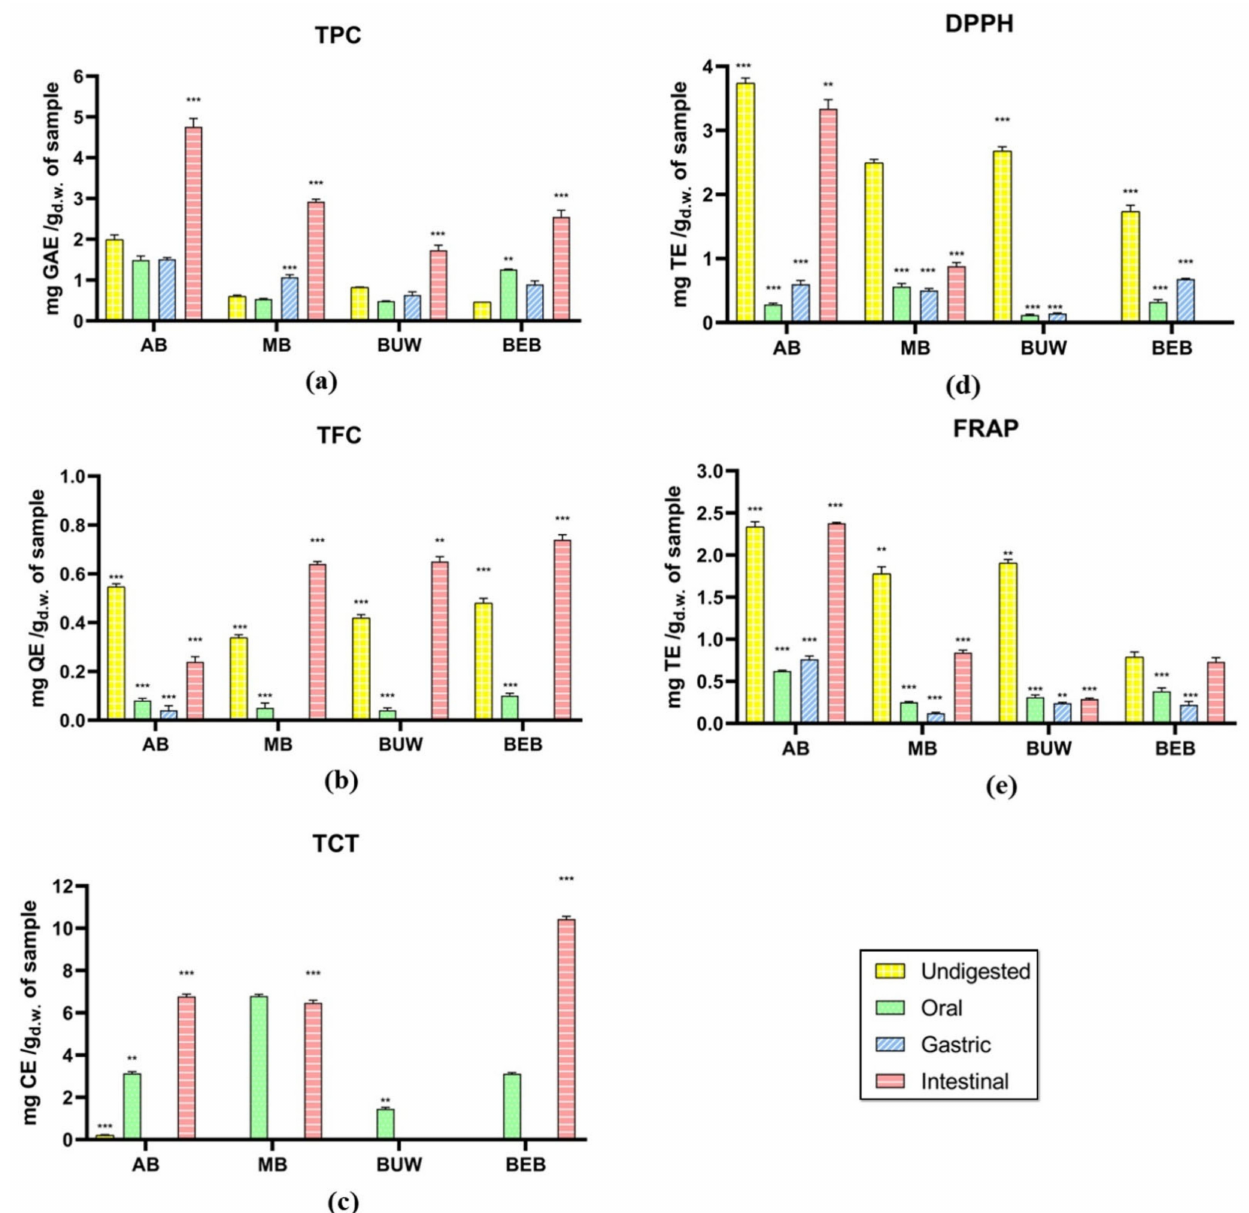
Figure 1. The evaluation of phenolic content and antioxidant capacity of different legumes in vitro digestates. ( a ) Total phenolic content; ( b ) total flavonoids content; ( c ) total condensed tannins; ( d ) 2,2 (cid:48) -diphenyl-1-picrylhydrazyl antioxidant assay; ( e ) ferric reducing antioxidant power assay. The results of all assays were pure values that have been subtracted the values of control. Legume samples mentioned in abbreviations are Adzuki Beans “AB”; Mung Bean “MB”, Black Urid Whole “BUW”, Black Eye Beans “BEB”. Yellow bars: Undigested phase; Green bars: Oral phase; Blue bars: Gastric phase; Pink bars: Intestinal phase. GAE: gallic acid equivalents; QE: quercetin equivalents; CE: catechin equivalents; TE: Trolox equivalents. **: Statistically significant different ( p ≤ 0.05); ***: Statistically very significant different ( p ≤